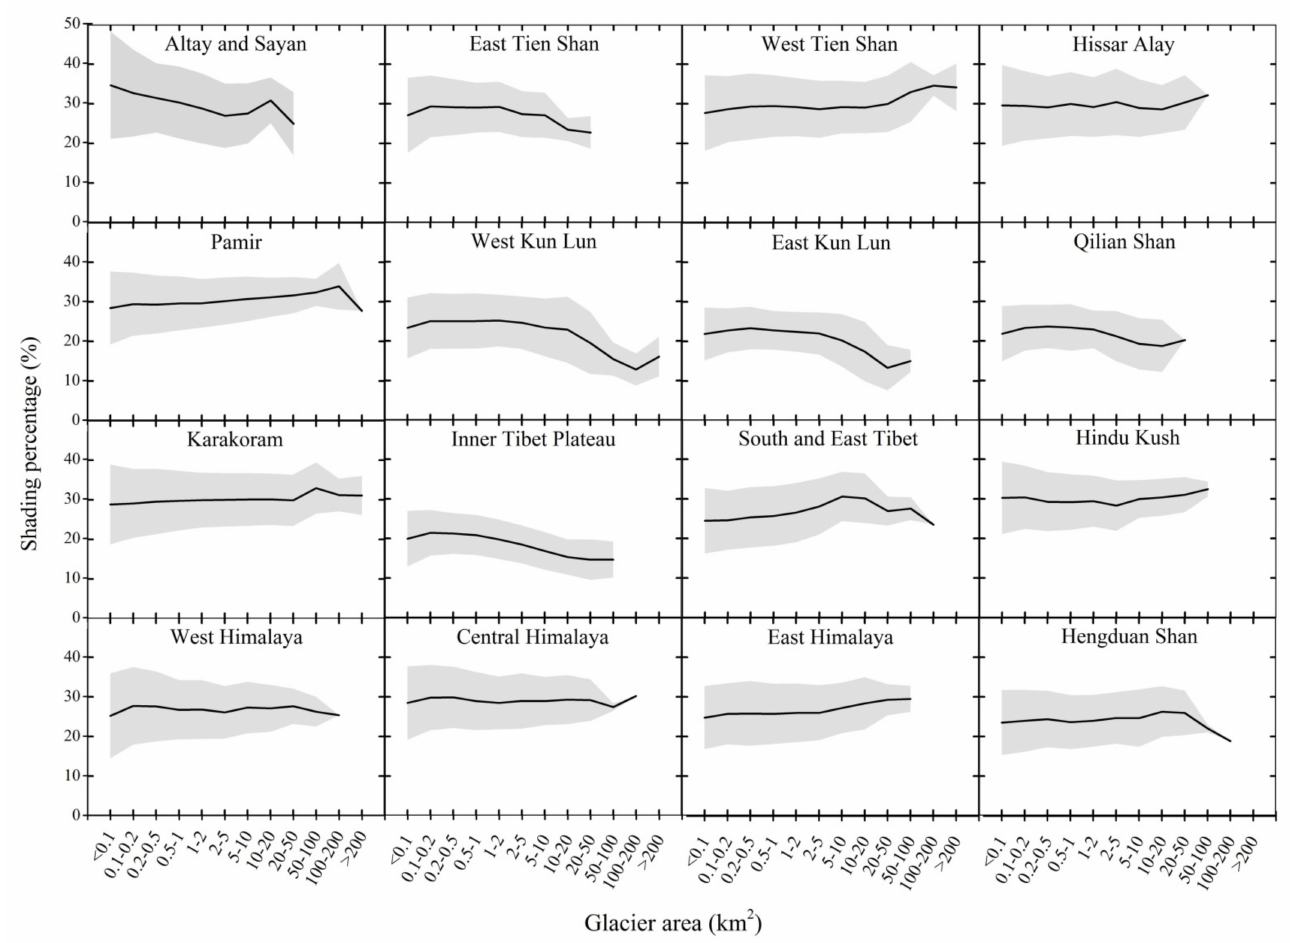
Figure 7. Changes in the glacier area with shading area percentages for each region within HMA. The black line is the average shading area percentage, and the gray shadow is the standard